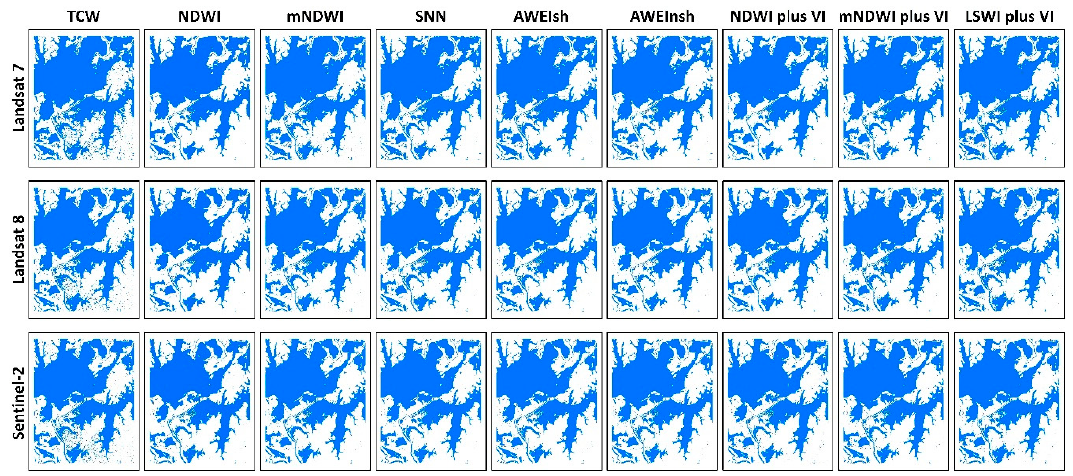
Figure 3. Contrast of the resultant open surface water body maps from 27 combinations of the nine algorithms (refer to Table 2) and the three sensors (Landsat 7 ETM+, Landsat 8 OLI, and Sentinel-2 MSI).